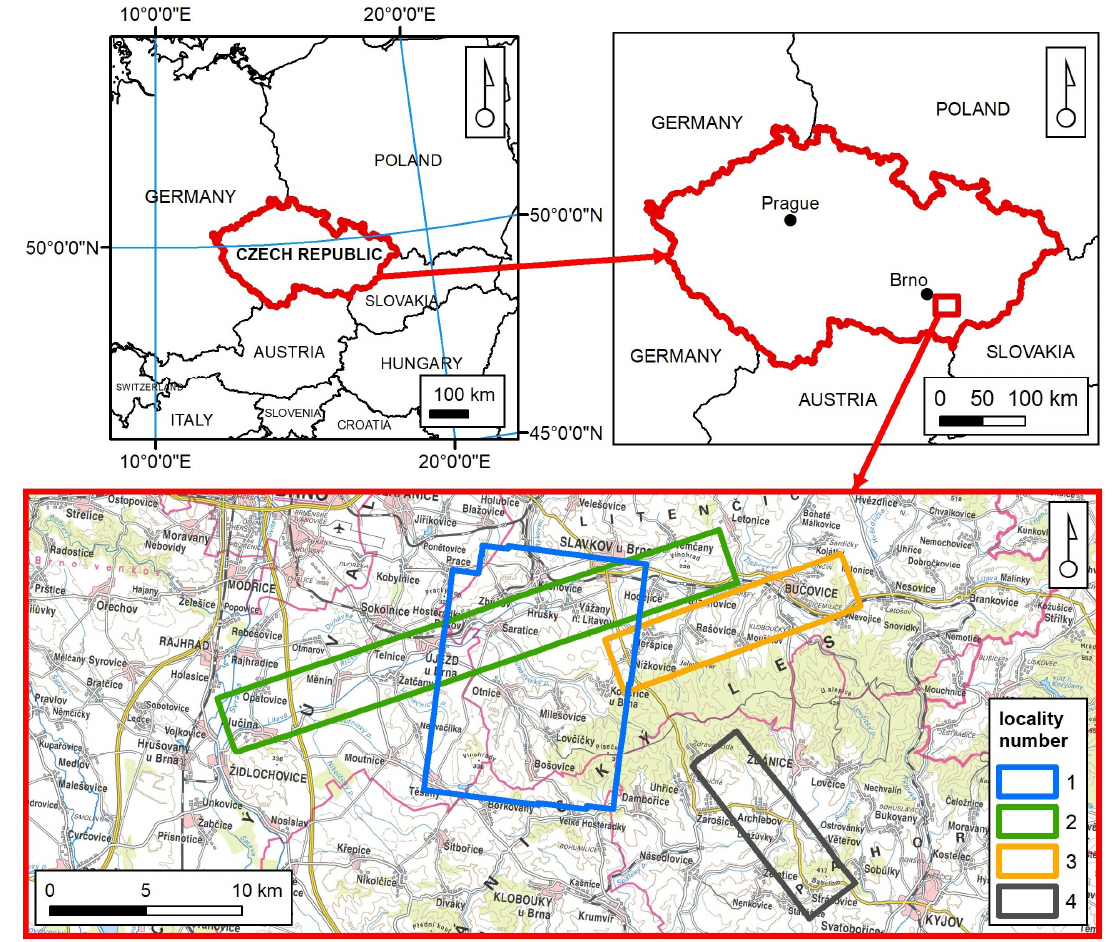
Figure 3. Areas of interest correspond to the 2016, 2017, and 2020 imaging campaigns. Table 1. Soil wetness of individual locations about one week before aerial imaging (IN- TERSUCHO. Available online: https://www.intersucho.cz/ (accessed on 12 Dec 2022).